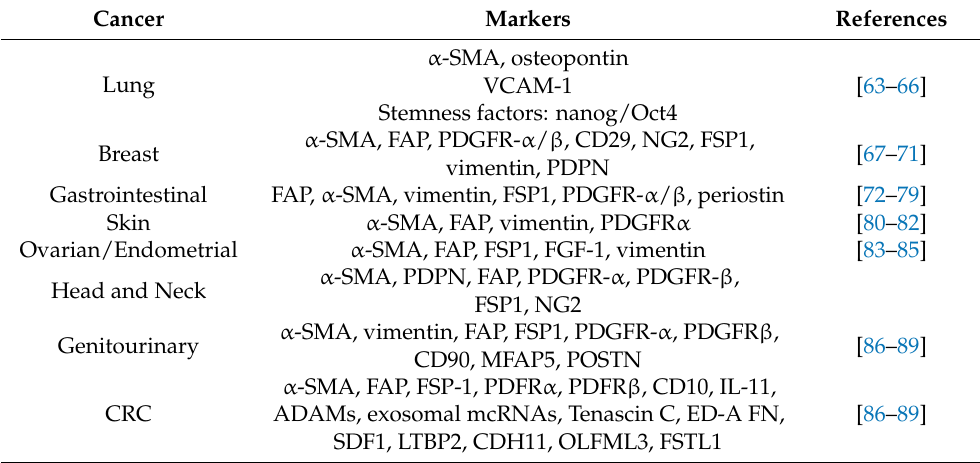
Table 1. Markers expressed in CAFs of different cancers. Cancer